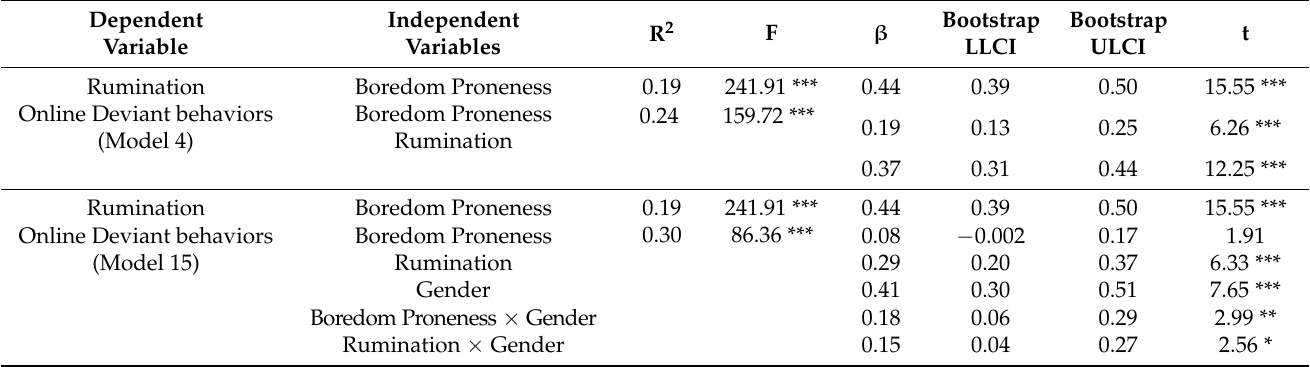
Table 2. The regression analysis of the moderated mediation model.